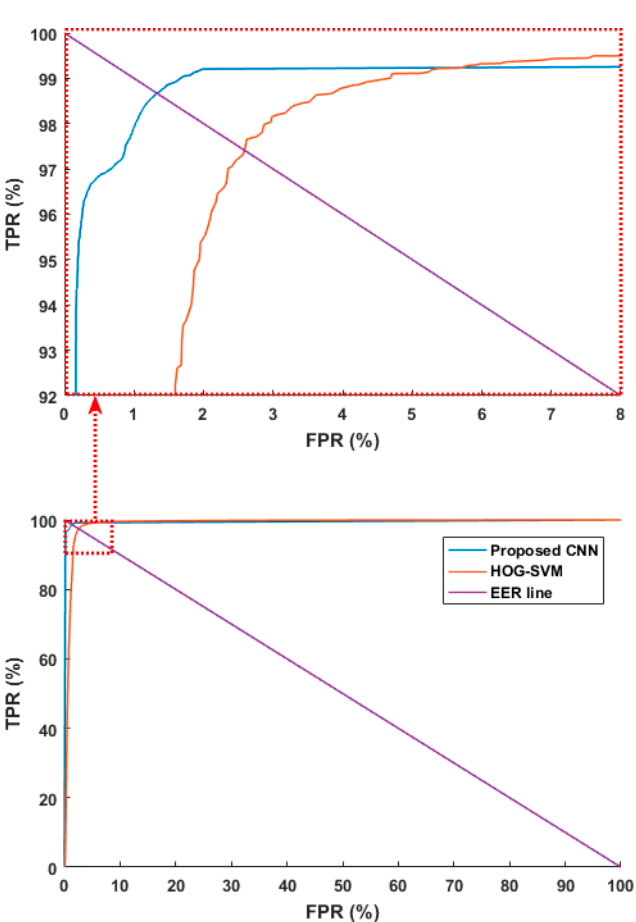
Figure 9. ROC curves of human and background detection by proposed and previous methods [16,42]. ROC curves in the part ranges of FPR and TPR ( top ), ROC curves in the whole ranges of FPR and TPR ( bottom )